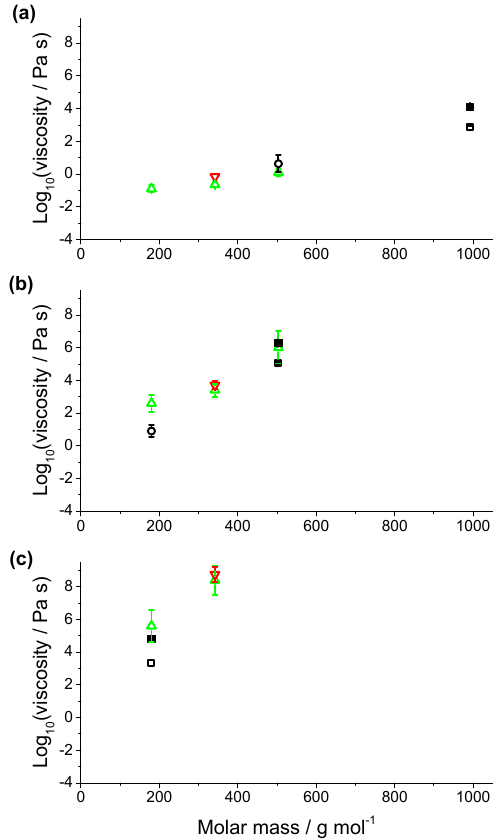
Figure 7. Plot of log 10 (viscosity/Pas) vs. molar mass at relative humidities of (a) 80%, (b) 55%, and (c) 30%. Viscosities mea- sured here are shown in black; circle symbols correspond to mea- surements made using the bead mobility technique, with error bars corresponding to an uncertainty of 2 σ , and square symbols corre- spond to the lower (open symbols) and upper (filled symbols) lim- its of viscosity determined using the poke-and-flow technique, with uncertainties corresponding to 95% confidence intervals. Literature values from Power et al. (2013) and Song et al. (2016) are repre- sented using red downward-pointing triangles, and green upward- pointing triangles,